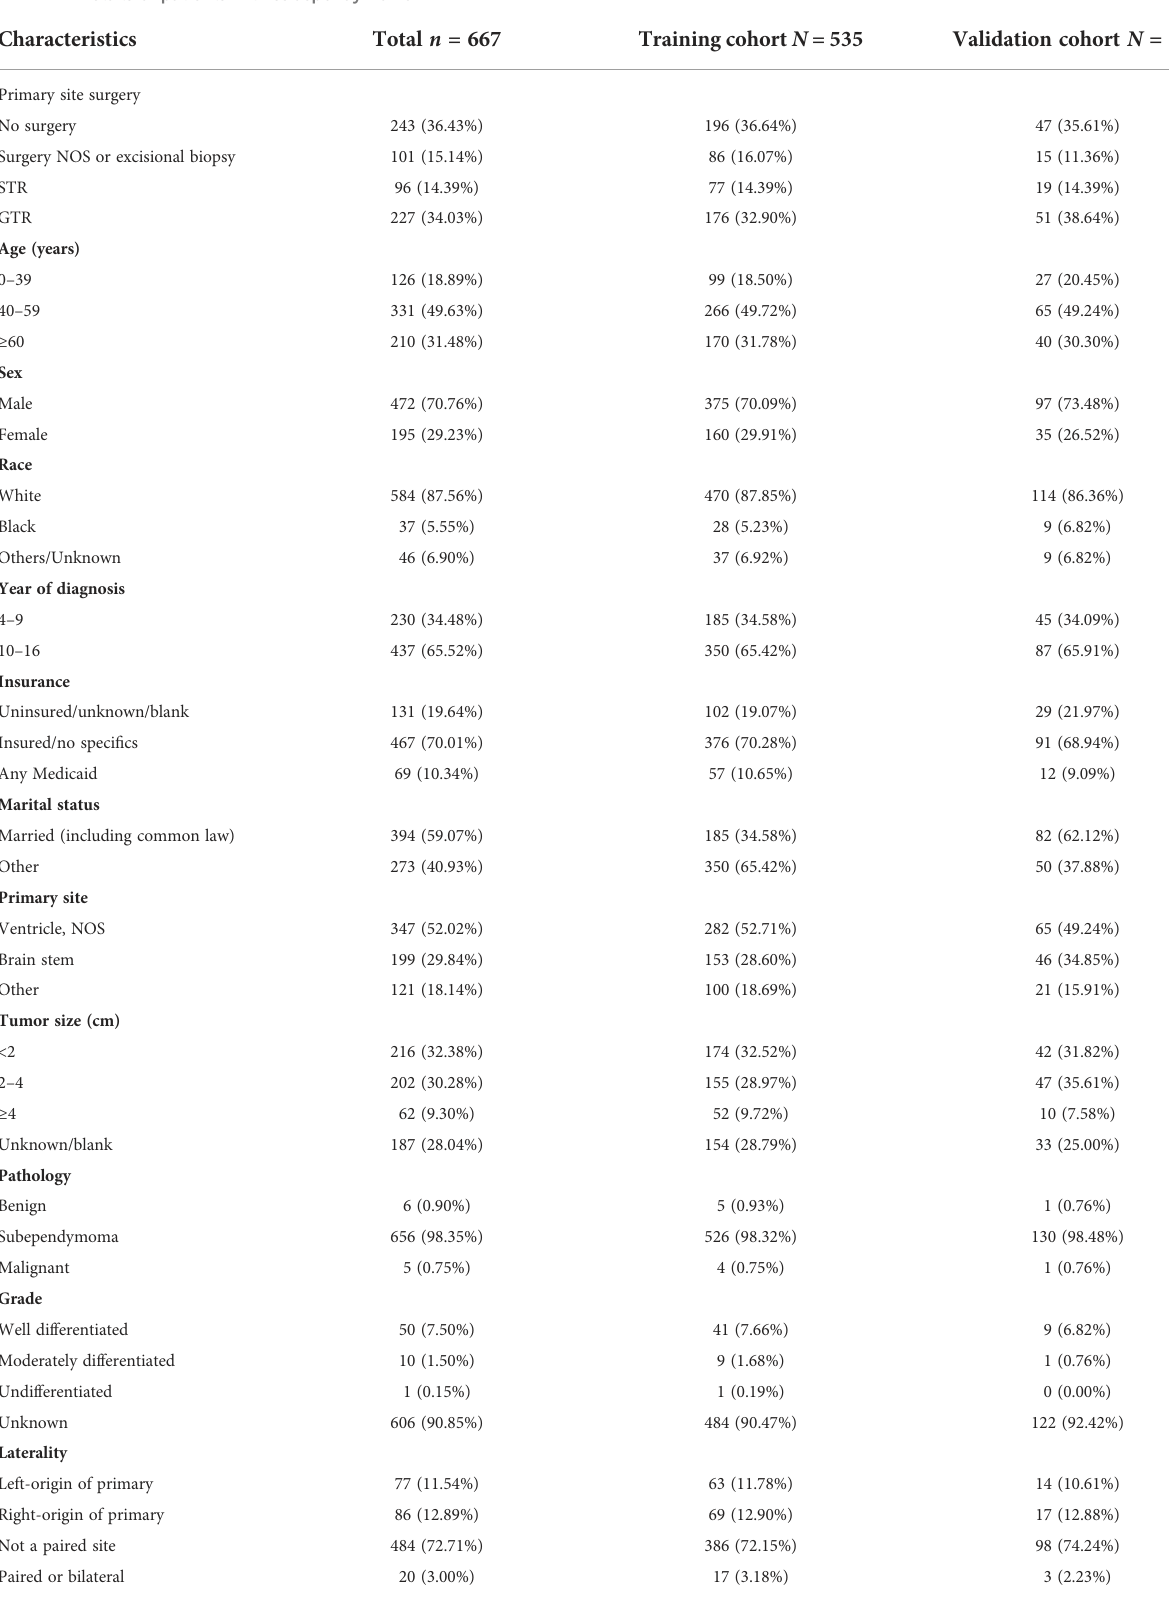
TABLE 1 Details of patients with